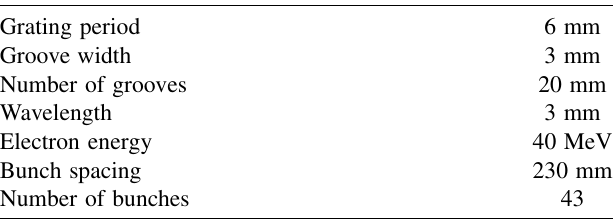
TABLE II. Parameters of the RRIKU